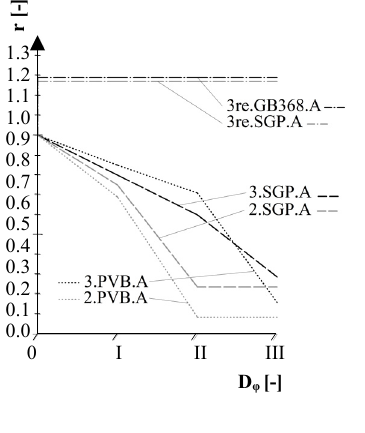
Figure 7.22: Relative redundancy curves for heat strengthened glass beams.